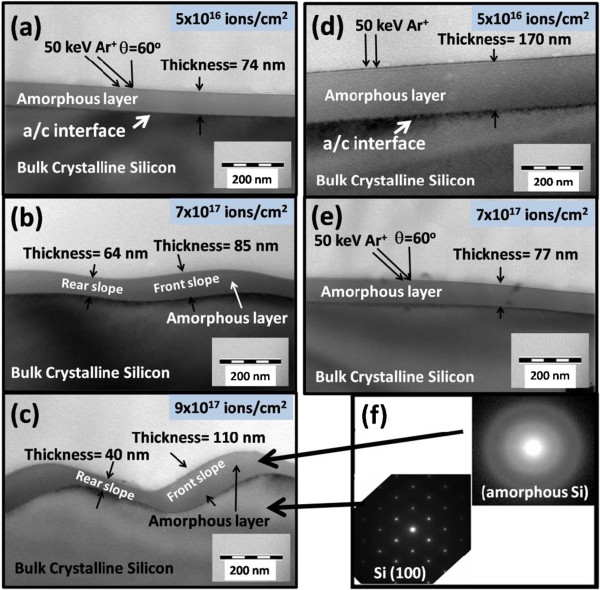
X-TEM images of 50 keV Ar+-irradiated set A samples. At the fluences of (a) 5 × 1016, (b) 7 × 1017, (c) 9 × 1017 ions per square centimeter, and set B samples (d) 5 × 1016 (for normal incidence) and (e) 7 × 1017 ions per square centimeter. SAED pattern for the amorphized and bulk crystalline regimes is in (f).